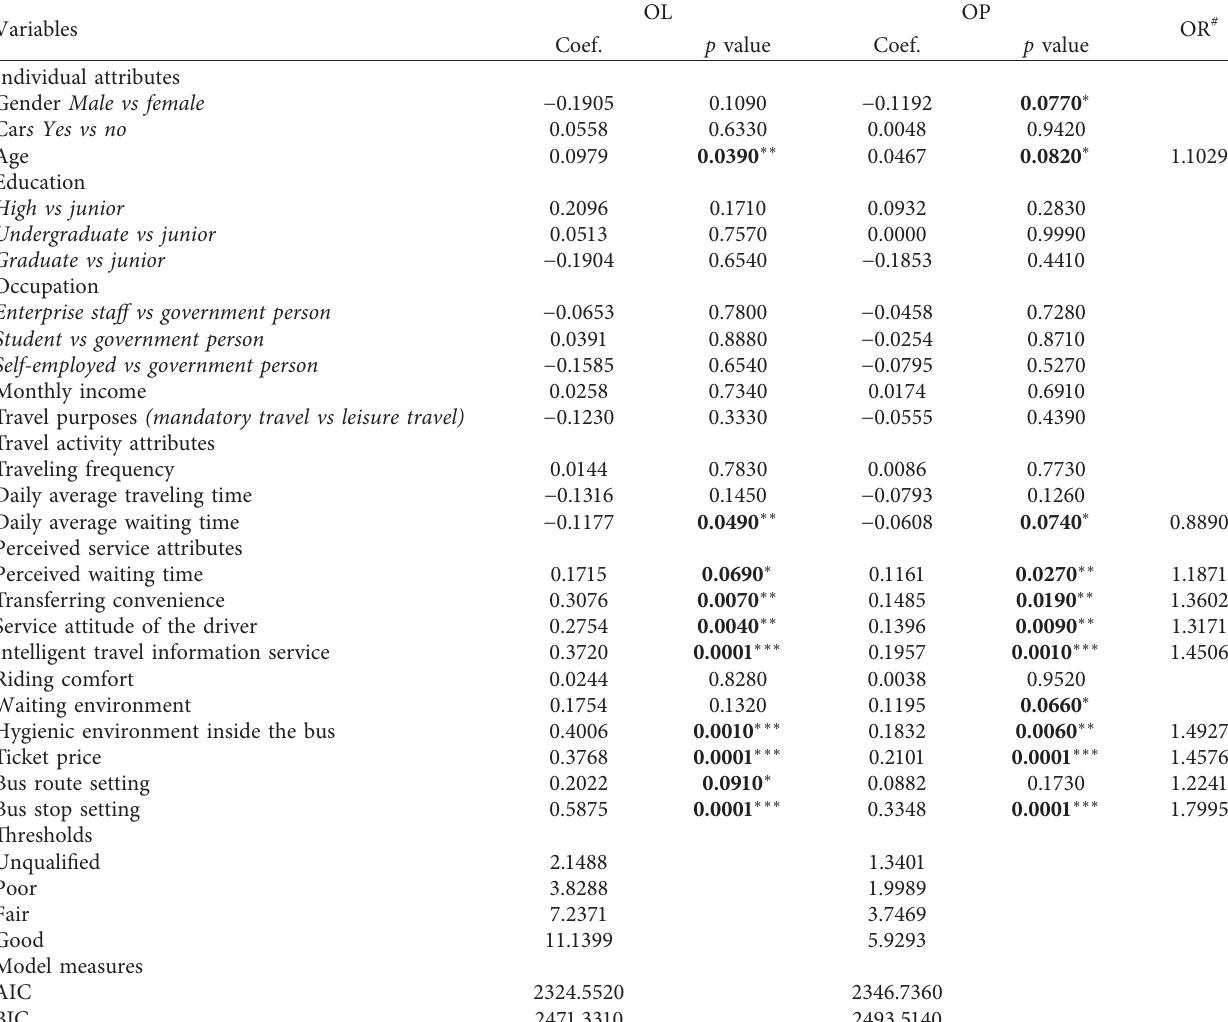
Table 5: Estimation results of the OL model and OP